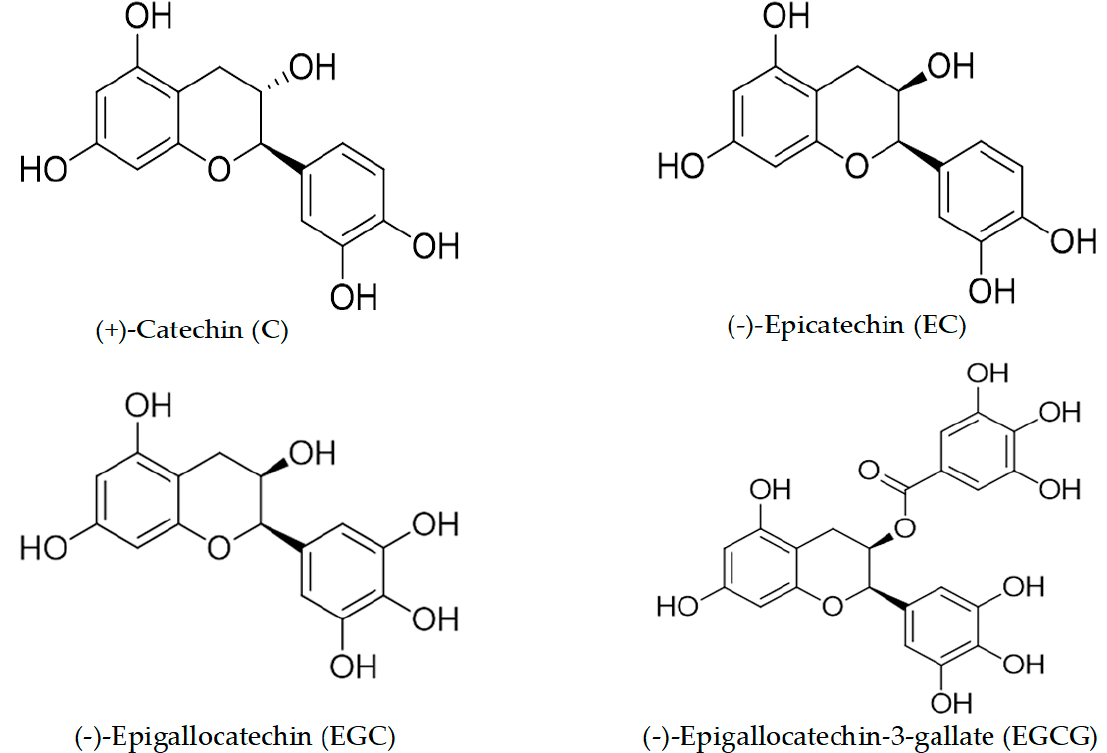
Figure 1. Structures of some tea catechins.